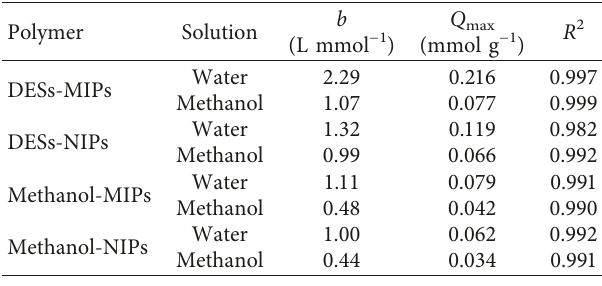
Figure 4: Static adsorption curves in water (a) and methanol (b) of the DESs-MIPs, DESs-NIPs, methanol-MIPs, and methanol-NIPs. Table 3: Langmuir fitting parameters for DESs-MIPs, DESs-NIPs, methanol-MIPs, and methanol-NIPs.